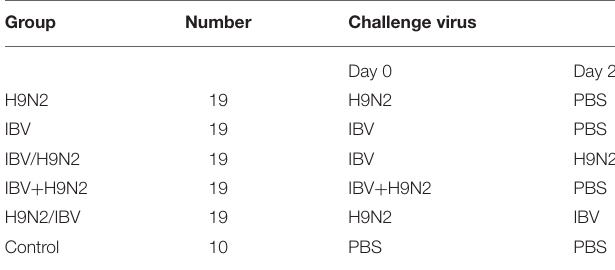
TABLE 1 | Animal experimental